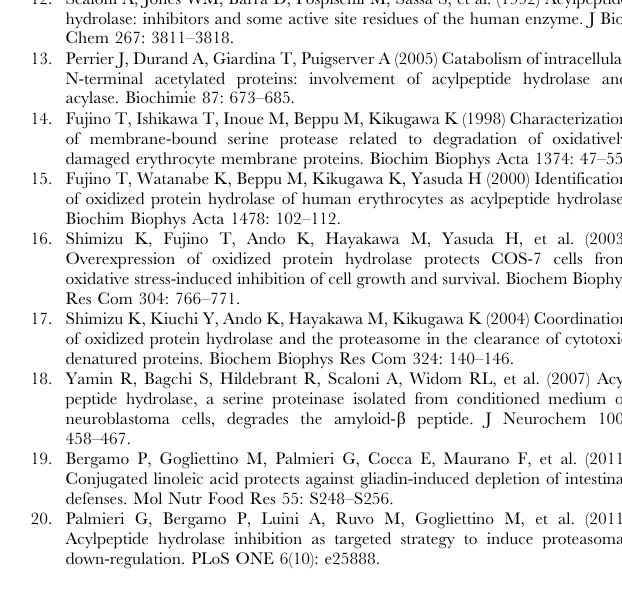
Figure S2 Transcriptional analysis under stress condi- tions. ( A ) Transcriptional levels of apeh Ss (white bars) with respect to apeh-3 Ss (gray bars) genes under oxidative stress or standard (insert) conditions during the exponential growth phase. ( B ) Transcriptional levels of apeh Ss (white bars) with respect to apeh-